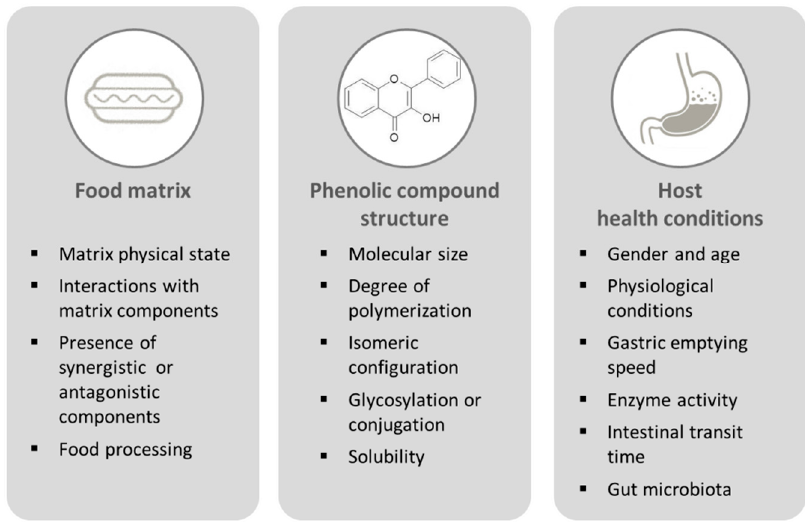
Figure 2. Factors affecting phenolic compound bioaccessibility and bioavailability. Figure 2. Factors a ff ecting phenolic compound bioaccessibility and